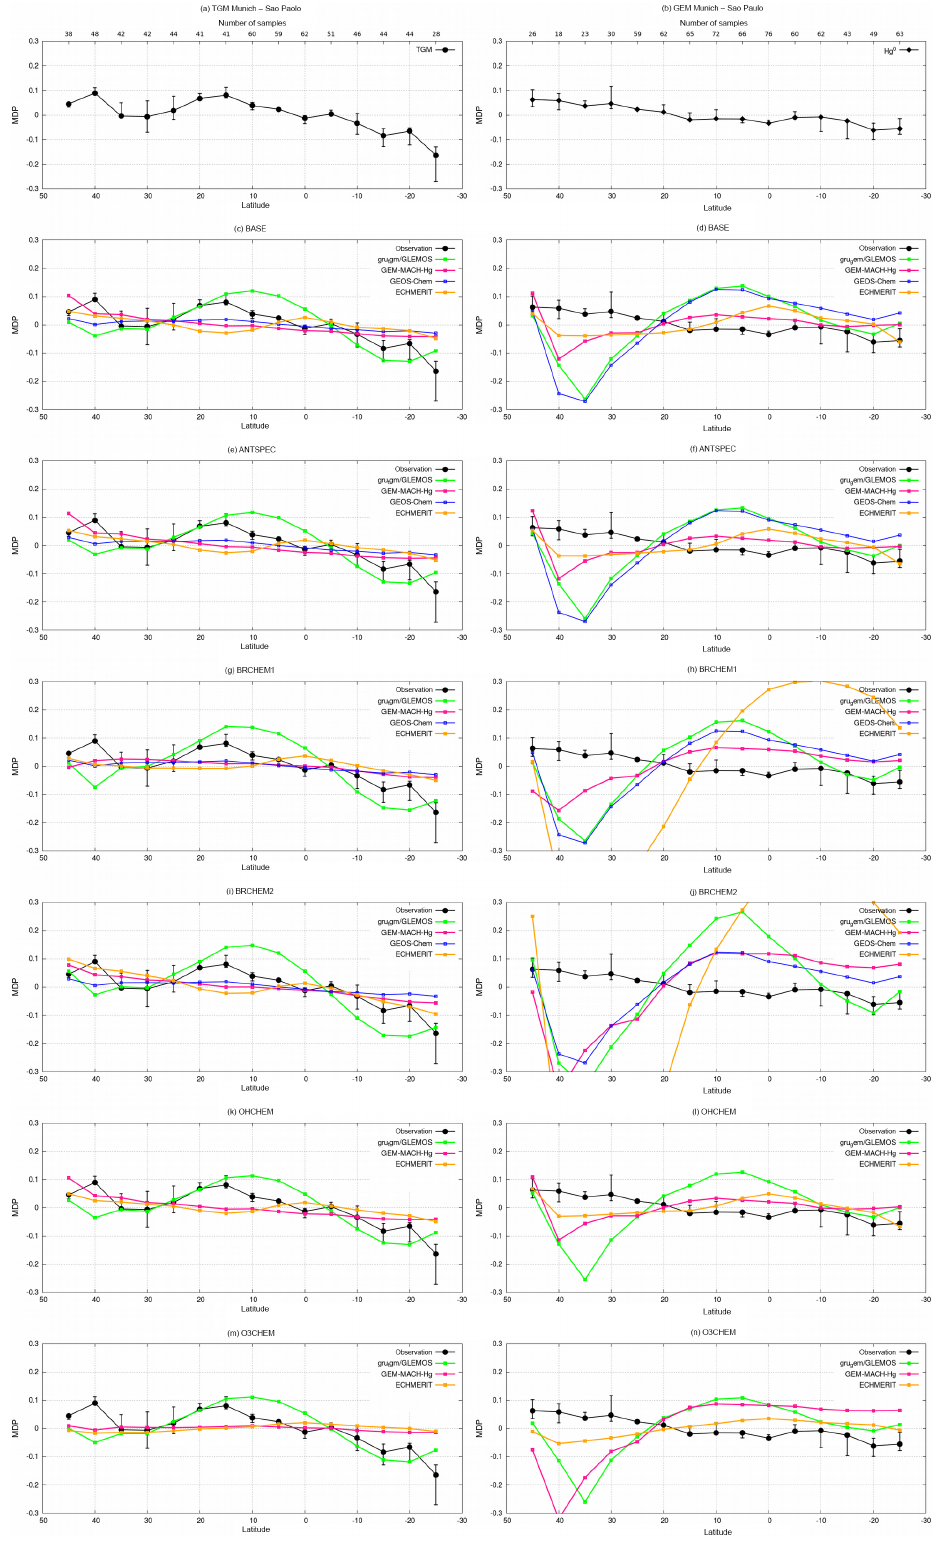
Figure 13. Relative interhemispheric transects for 19 flights from Munich to Sao Paulo. TM (left side) was measured on the outward and GEM (right side) on return flights (Slemr et al., 2014). Error bars indicate the 66% quantile range of all observations for a given latitude. Plot in the left column are for TGM and in the right column for